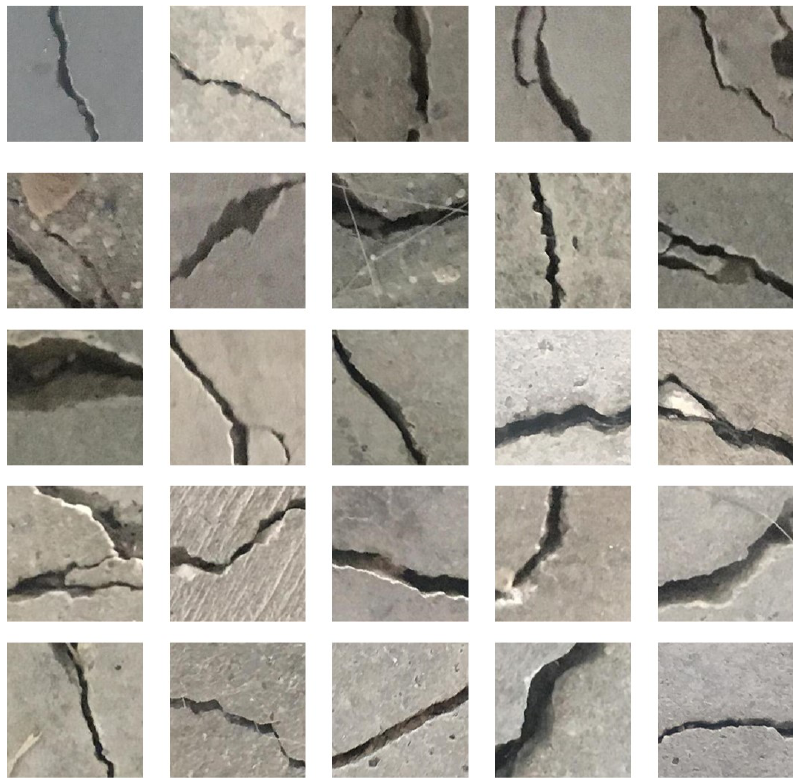
Figure 6. The concrete crack dataset that contains the images of the cracks.